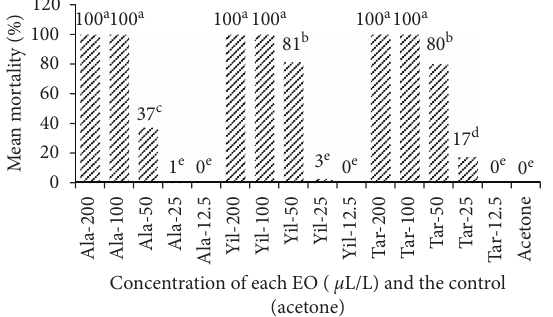
Figure 4: Percent mortality of larvae at different doses of EOs and acetone.